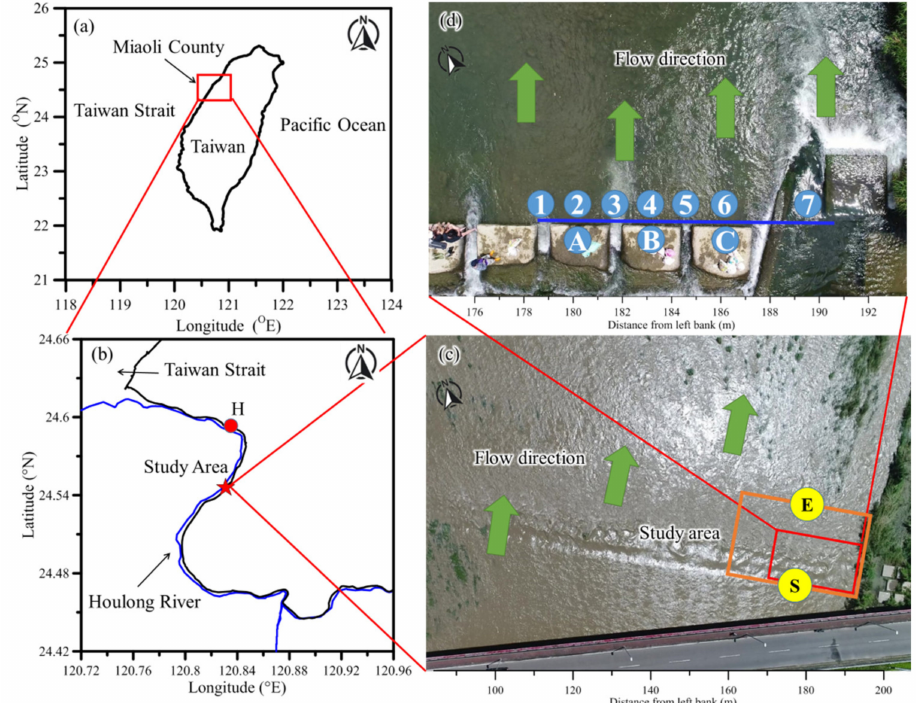
Figure 1. Map showing ( a ) the location of Miaoli County in Taiwan, ( b ) the study area located along the Houlong River, where the symbol H represents discharge station, and ( c ) the groundsill works flooded during high flow period. The symbols S and E denote the start point and end point using the float method, respectively, and ( d ) the groundsill works exposed during the low flow period. The measurement locations from number 1 to number 7 using a flow meter and the artificial tracers (i.e., wood shavings) released at locations A, B, and C are illustrated in the